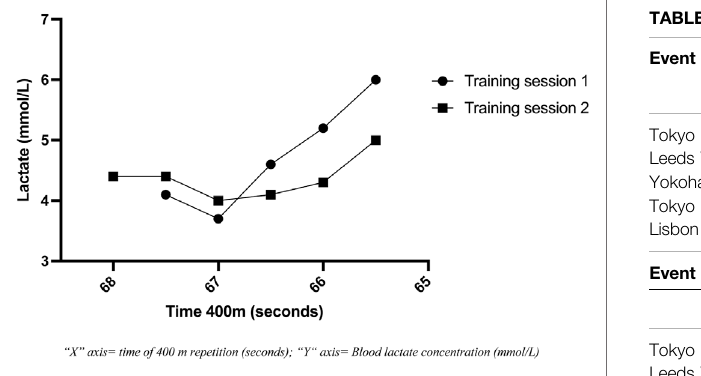
FIGURE4| Blood lactate concentration oftworunning training sessions in heat condition.